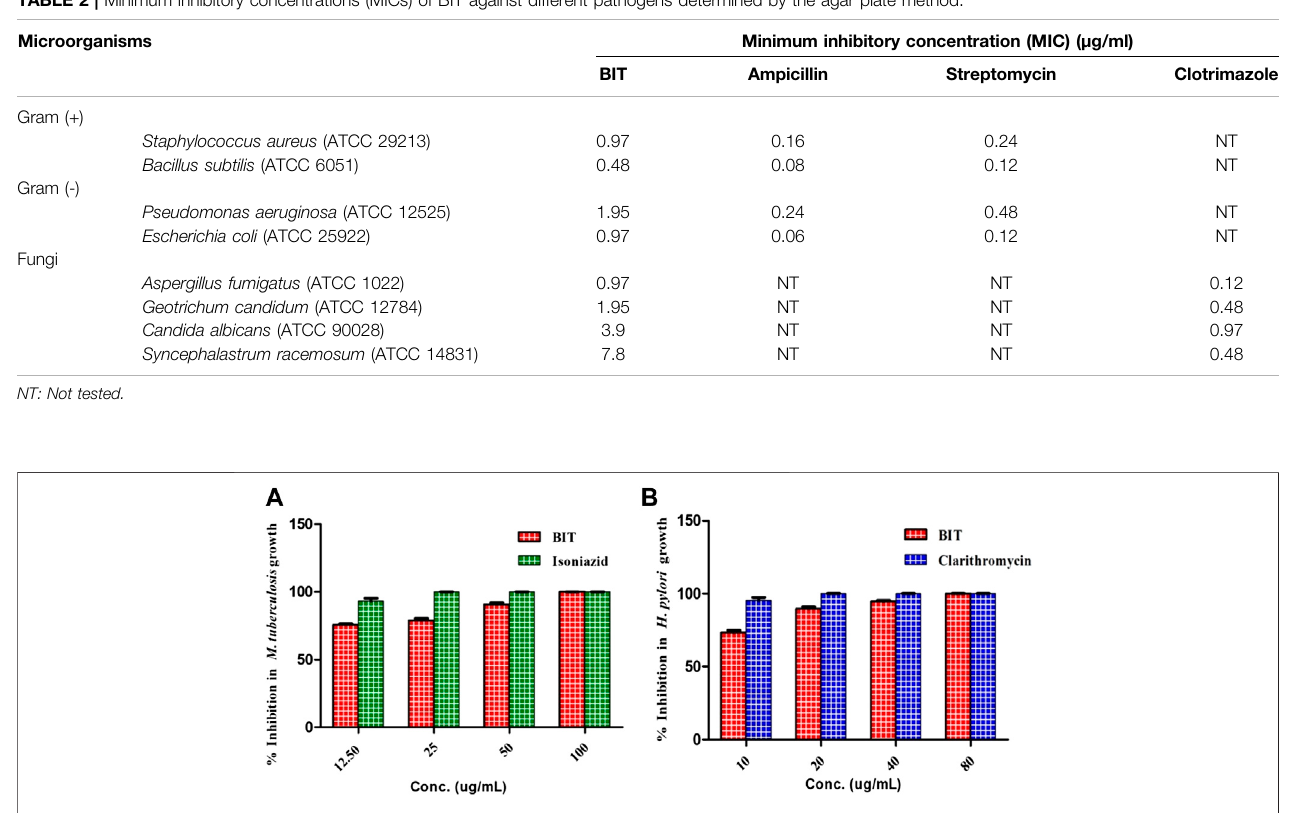
Frontiers in Pharmacology |